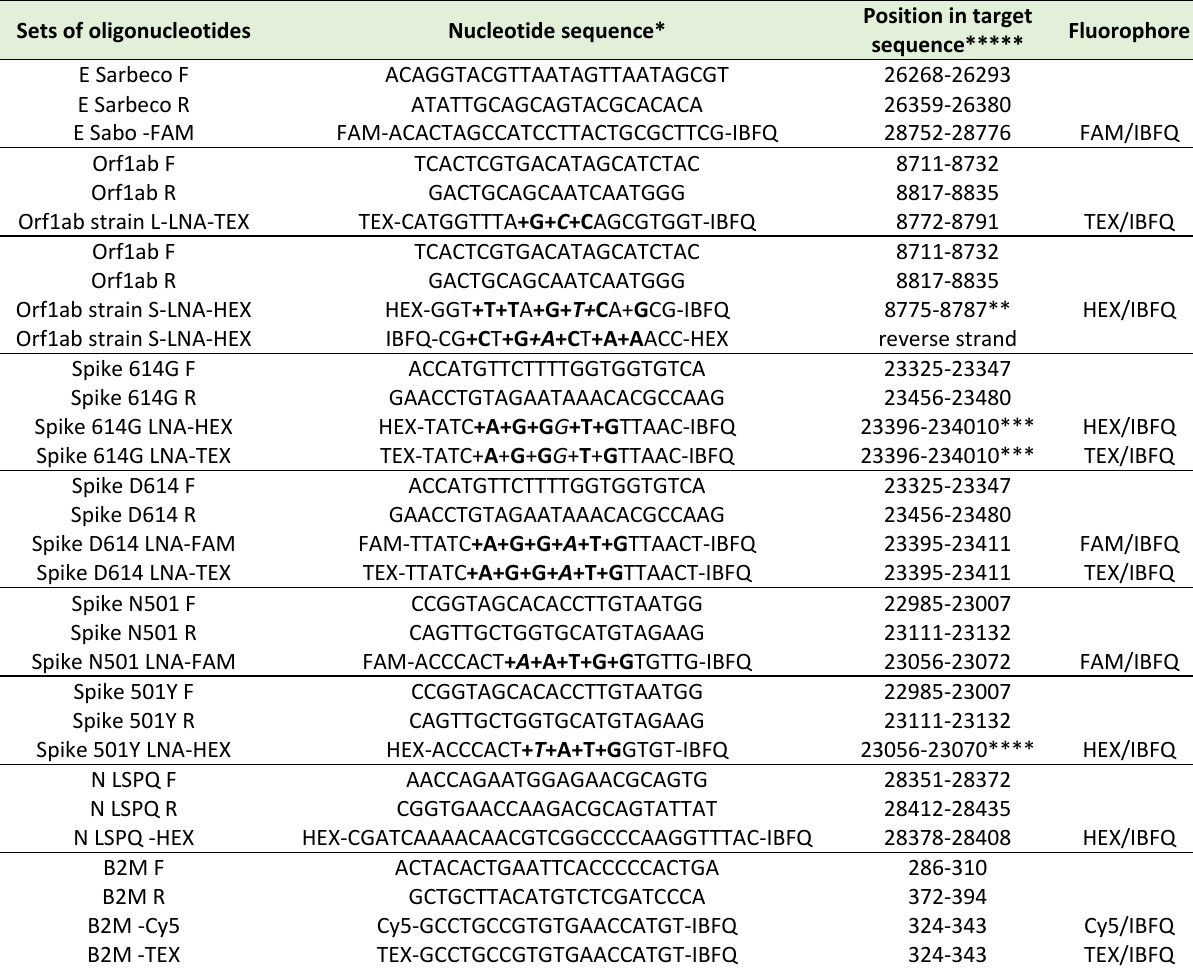
TABLE 1. Oligonucleotide primers and fluorogenic probes used in real-time quantitative RT-PCR assays. Sets of